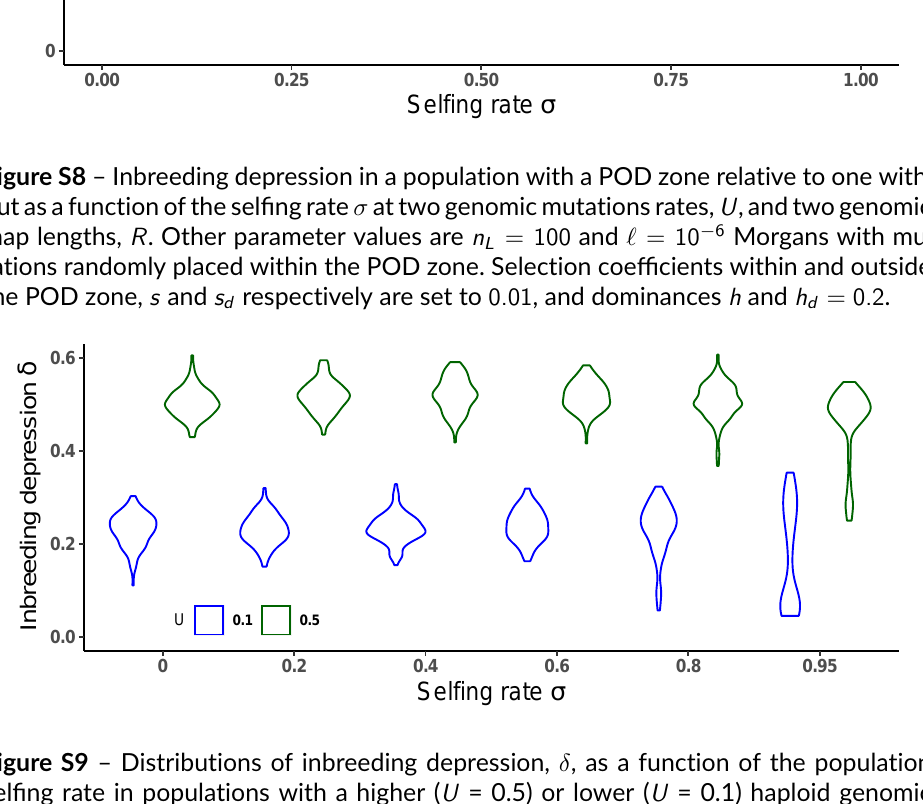
Figure S9 – Distributions of inbreeding depression, δ , as a function of the population selfing rate in populations with a higher ( U = 0.5) or lower ( U = 0.1) haploid genomic 6 mutation rate. Other parameter values: n L = 100 , ℓ = 10 − Morgans with mutations randomly placedin the POD zone. Selection coefficients within and outside the POD zone, s and s d respectively are set to 0.01 , and dominances h and h d = 0.2 . The genome size (setting the recombination rate) is R = 10